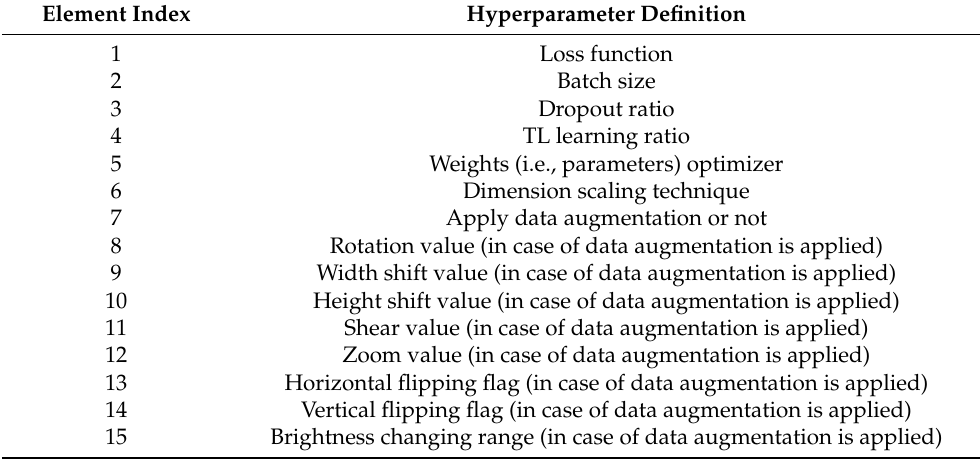
Table 1. The solution indexing with the hyperparameters